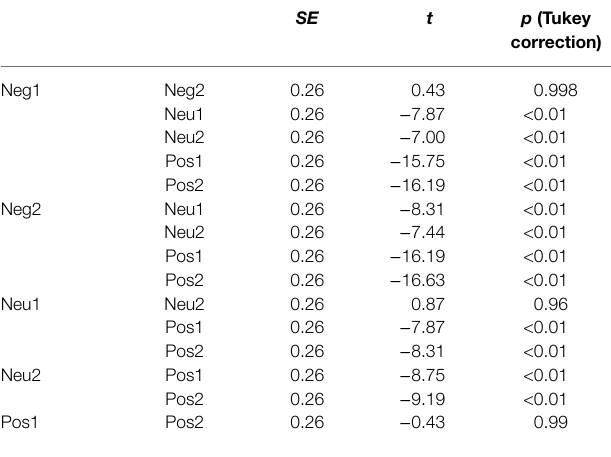
TABLE 6 | Post hoc comparisons of valence values (pilot